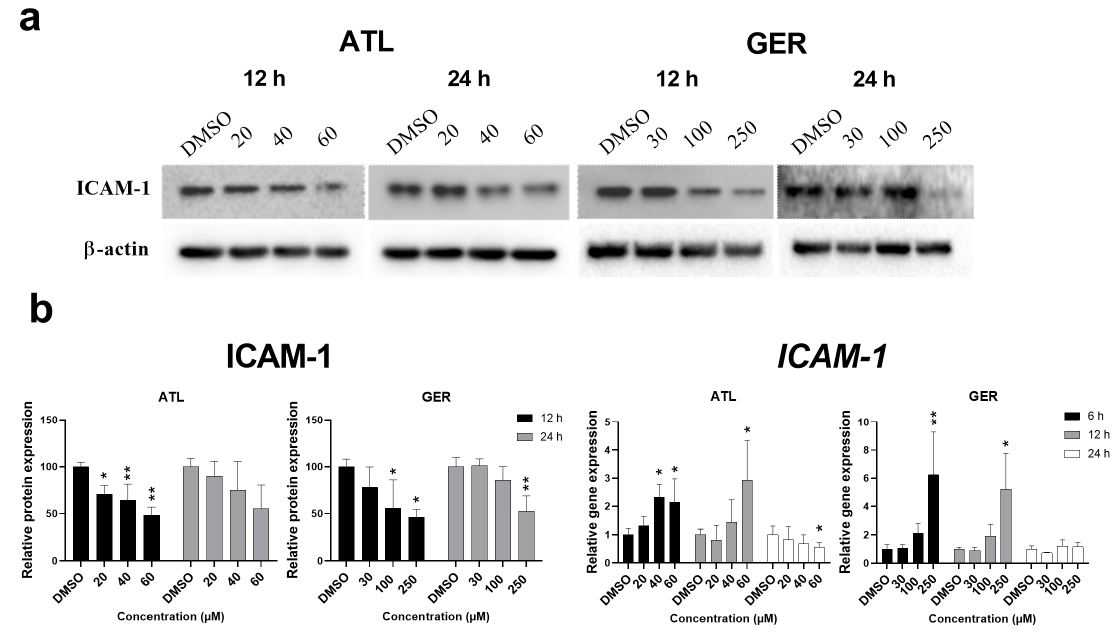
Figure 3. Expression changes in the intercellular adhesion molecule ICAM-1 after ATL and GER treatment of di ff erentiated HepaRG cells. ( a ) Representative western blots showing expression changes in ICAM-1. ( b ) Relative protein expression changes in ICAM-1 to β -actin and relative gene expression changes in ICAM-1 mRNA by RT-qPCR. Results are expressed as the mean ± SD from three independent experiments. Results statistically significant: p < 0.05 (*), p < 0.01 (**), p < 0.001 (***).